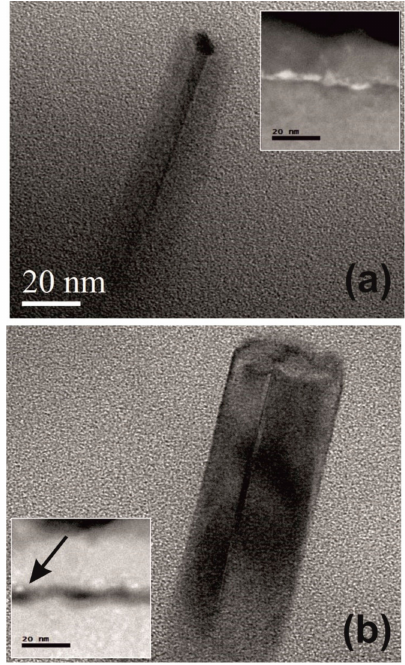
Figure 4. Cross-sectional view of TEM micrographs of Si-NWs after the gold removal single step ( a ), and after the two-step gold etching ( b ). Insets: STEM micrographs of the substrate / Si-NWs interface for the relative